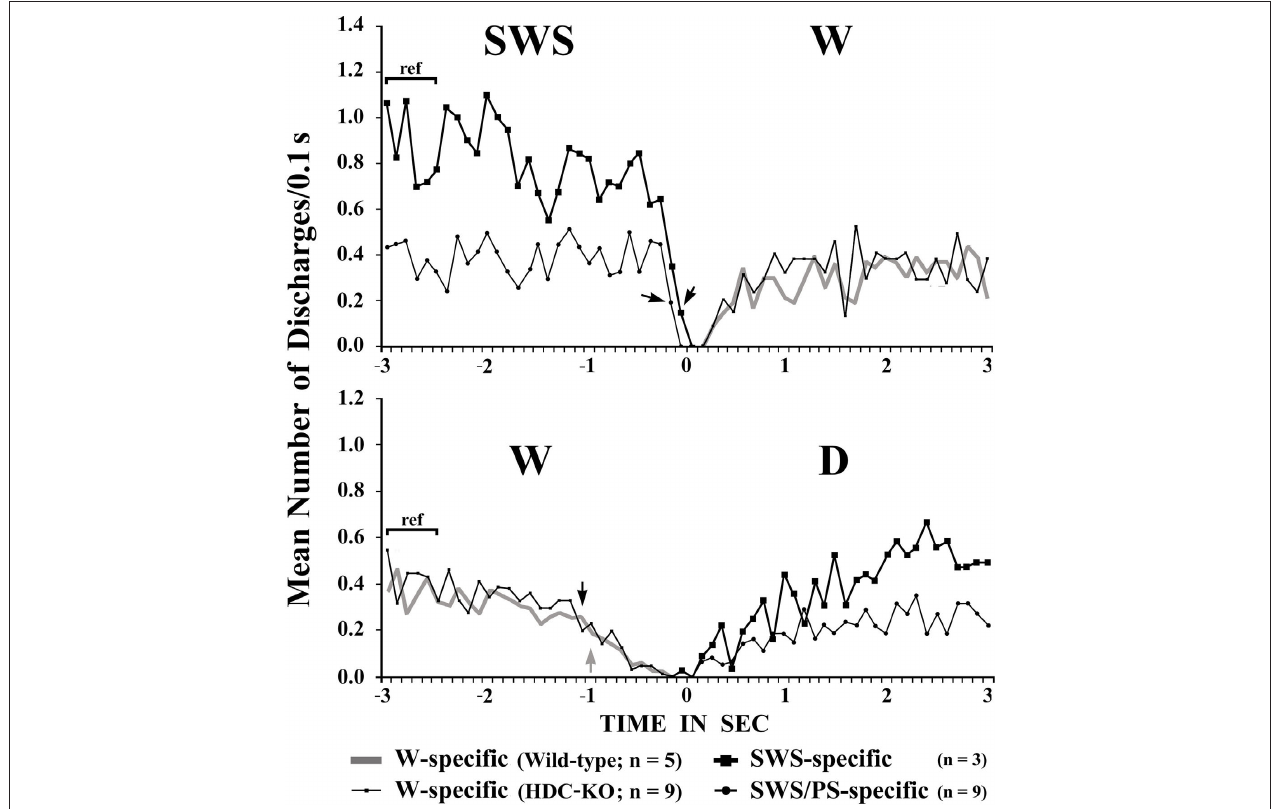
indicates the onset of EEG activation in the upper panel and the onset of EEG synchronization (deactivation) in the lower panel. The statistical significance of the difference between the discharge rate going from SWS to W (upper panel) or from W to drowsy state (lower panel) and the reference discharge rate seen during the 0.6-s period of SWS or W from 3 to 2.4 s before the onset of the state transition was examined. The arrows indicate the first point at which a statistically significant decrease in firing rate was observed